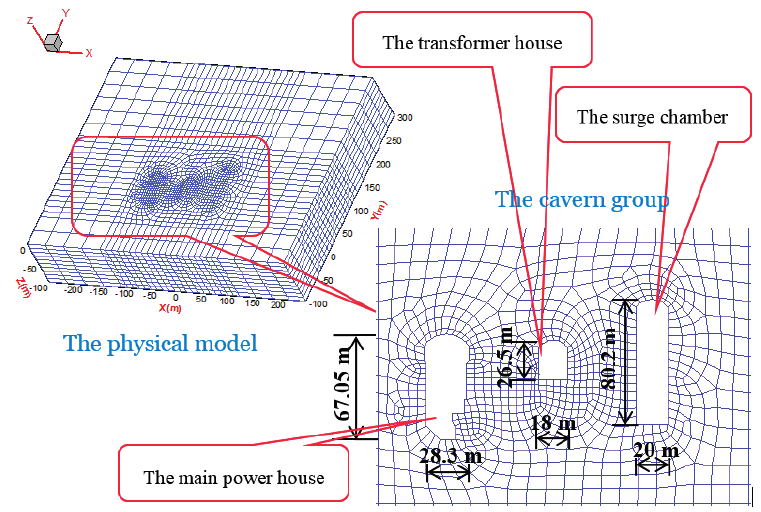
Figure 6. The layout of the physical model with the cavern group.